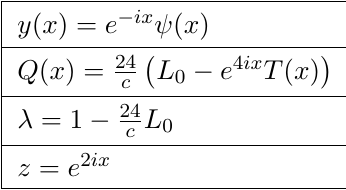
Table 2 . The constituents of the Hill system in terms of CFT